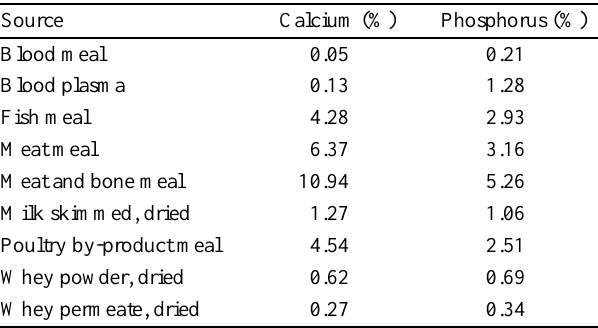
Table 3. Calcium and phosphorus concentration in animal feed ingredients